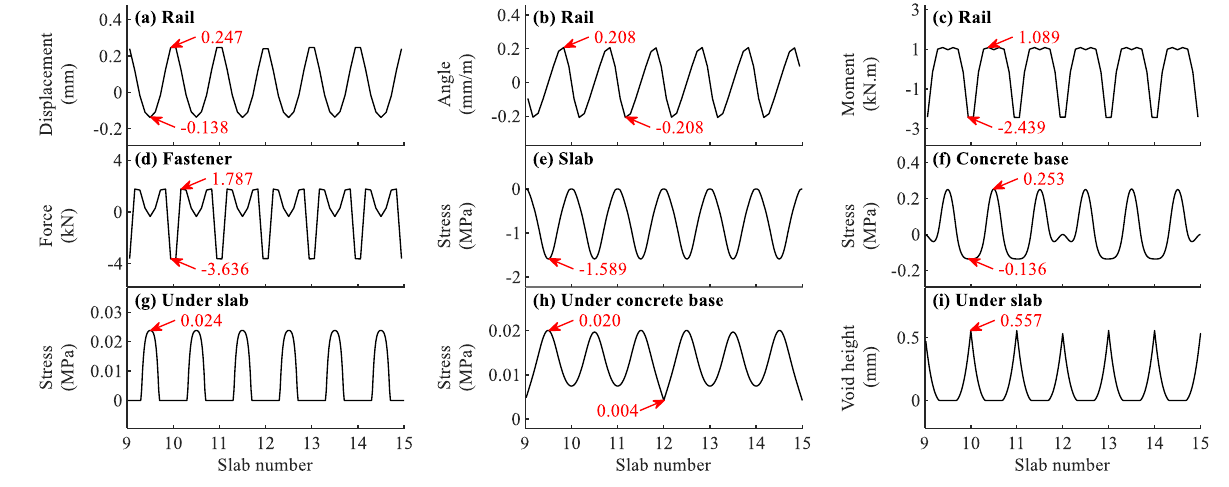
Figure 4. The initial state of slab track for different items when f = -45 °C/m.